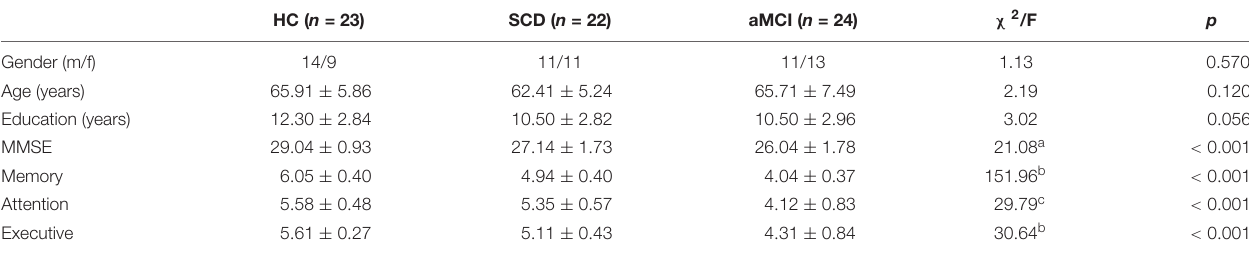
FIGURE 1 | Workflow of data analysis. White matter matrices were constructed based on the AAL template, an automated anatomical parcellation of the spatially normalized single-subject high-resolution T1 volume, during which indexes (GE, SP, LE, and CE) at the network and nodal level were extracted. At the network level, four indexes, including GE, SP, LE, and CE were used separately or combined to build a classifier. GE, global efficiency; SP, short path length; LE, local efficiency; CE, clustering coefficient. At the nodal level, each index includes 90 features. To select the most discriminate features, LSVM (an outer LOOCV) was nested with a feature selection produce (an inner LOOCV). LSVM, linear support vector model; LOOCV, leave-one-out cross-validation. Similar to nodal level, four indexes were used separately or combined to build a classifier. TABLE 1 | Demographics and neuropsychological